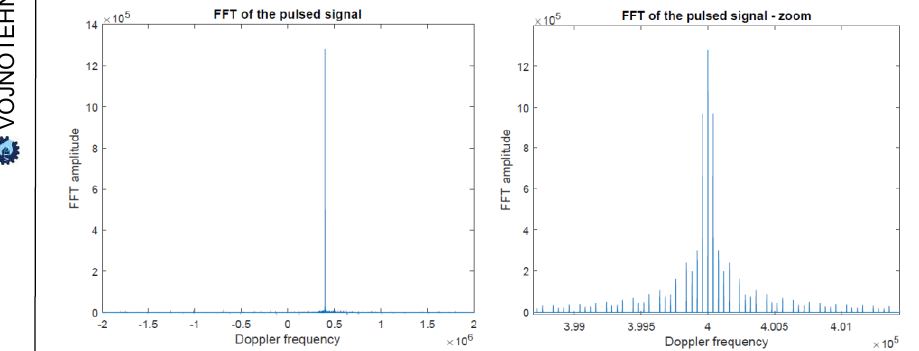
Figure 2 – Spectrum of the pulsed signal modulated with the Doppler frequency Рис. 2 – Спектр импульсного сигнала, модулированного доплеровской частотой Слика 2 – Спектар импулсног сигнала модулисаног Доплеровом